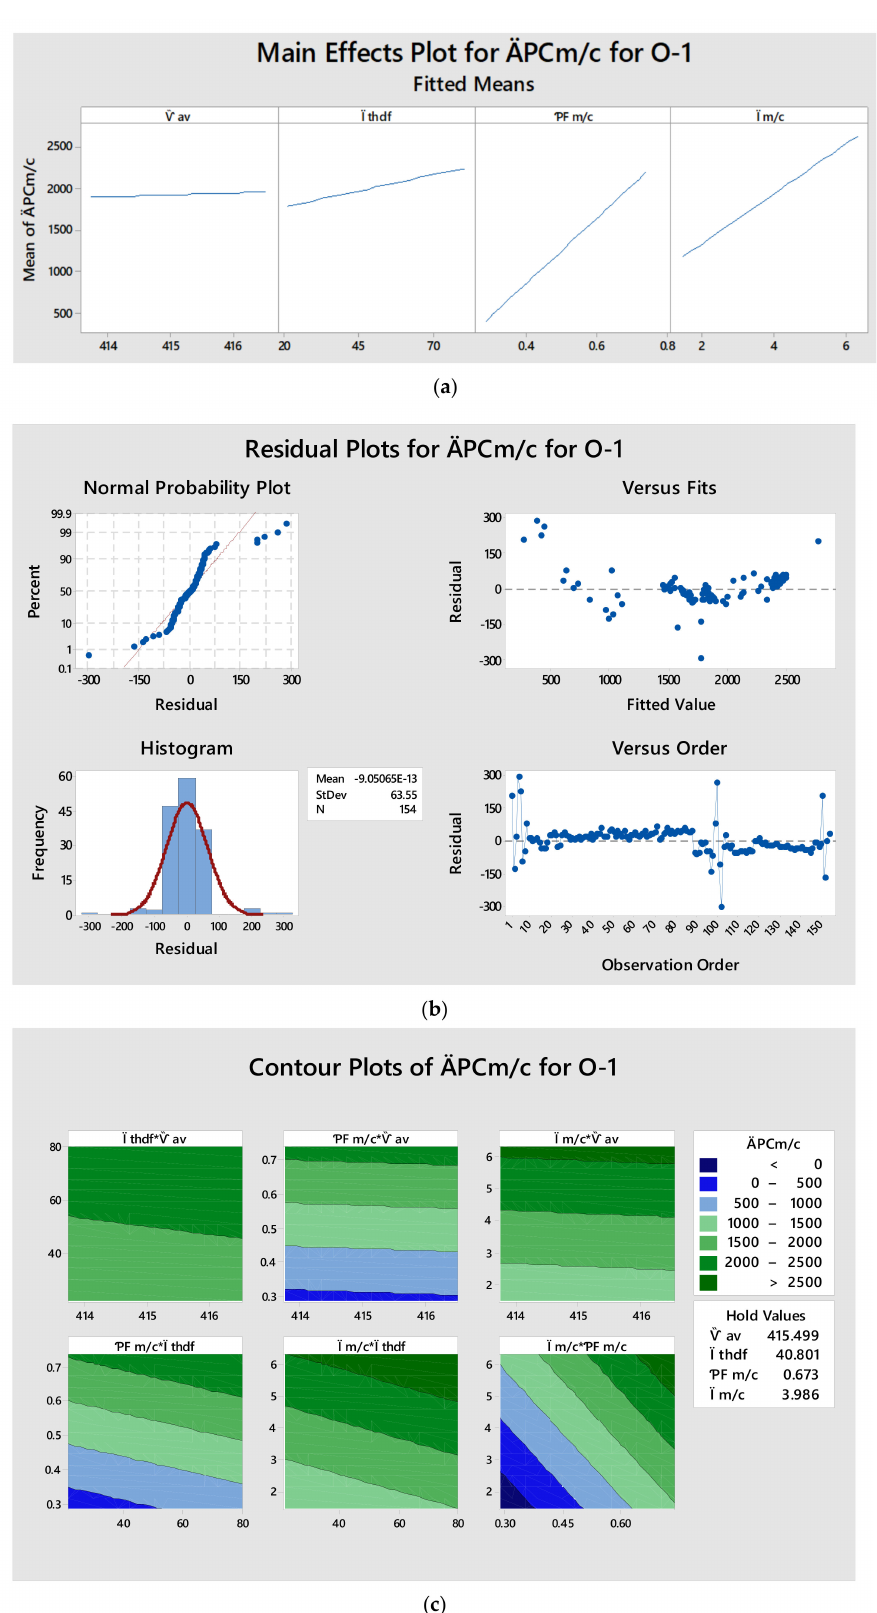
Figure 4. ( a ) Main effects plot for O-1. ( b ) Residuals plot for O-1. ( c ) Contour plots for